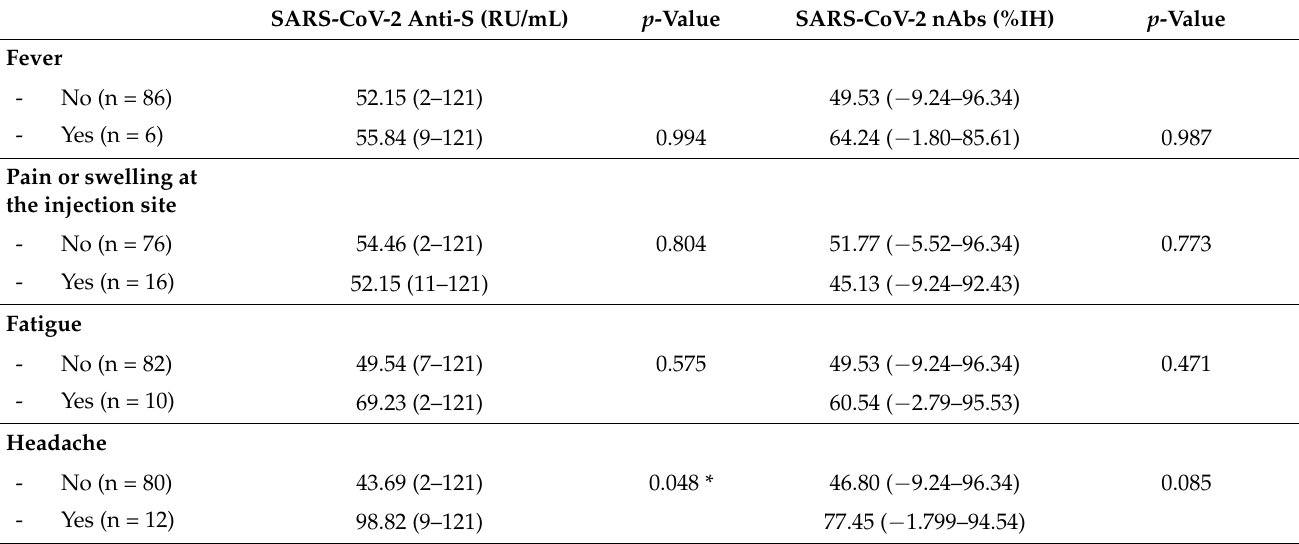
Table 8. Quantitative analysis of SARS-CoV-2 anti-S titers and %IH of nAbs and short-term adverse reactions after Sinopharm COVID-19 vaccination.